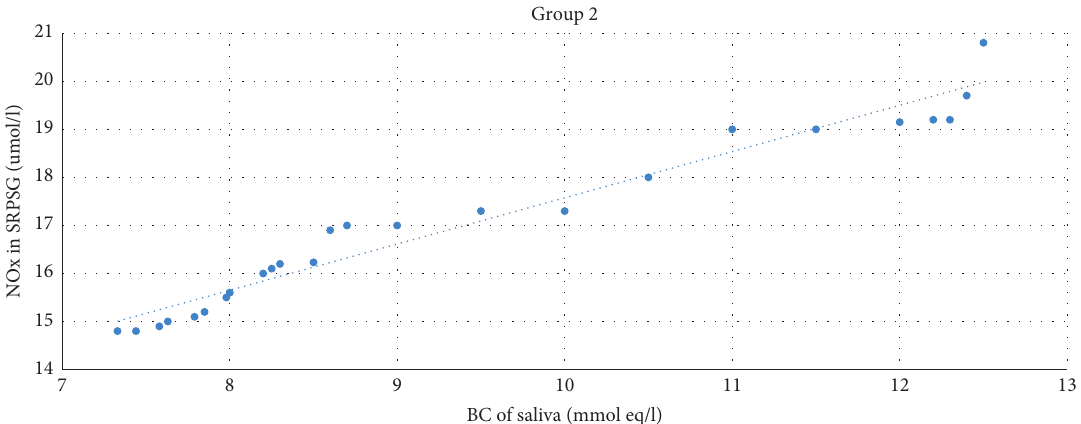
Figure 9: The correlation between the NOx level in SRPSG and the buffer capacity of saliva among patients in Group 2.